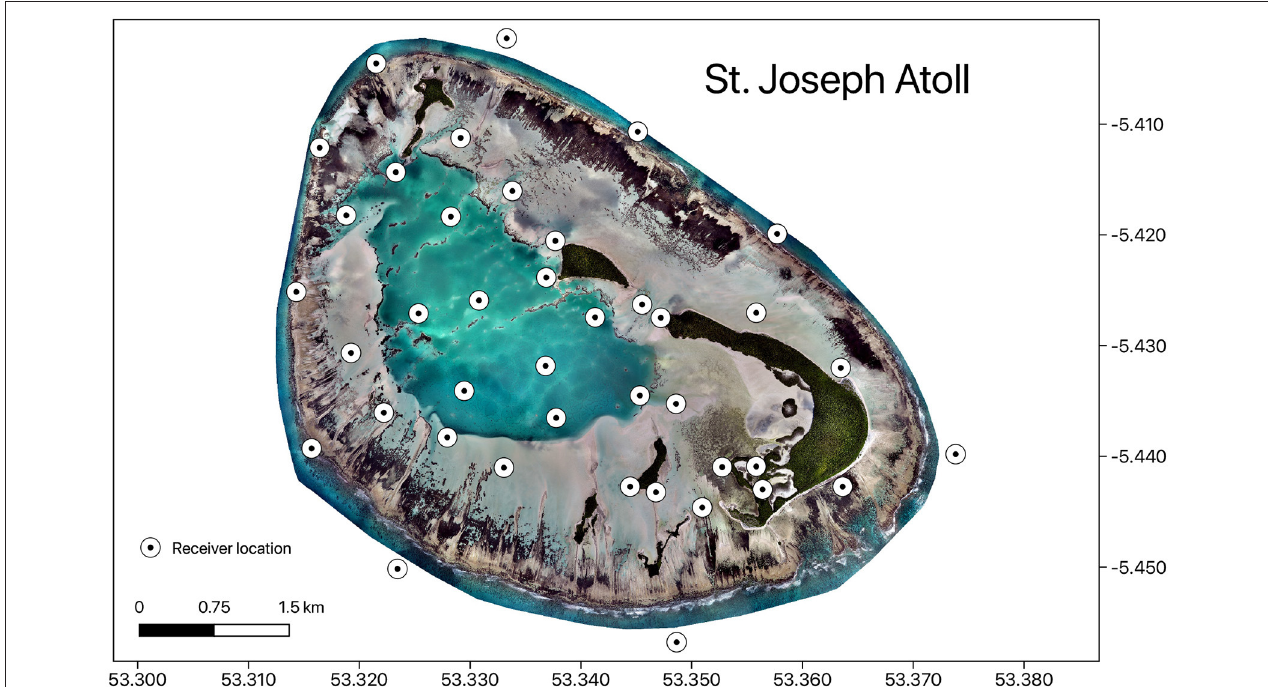
FIGURE 1 | Map showing the distribution of acoustic receivers in St. Joseph Atoll. Map was produced in QGIS using drone image, Copyright of Drone Adventures for the Save Our Seas Foundation.